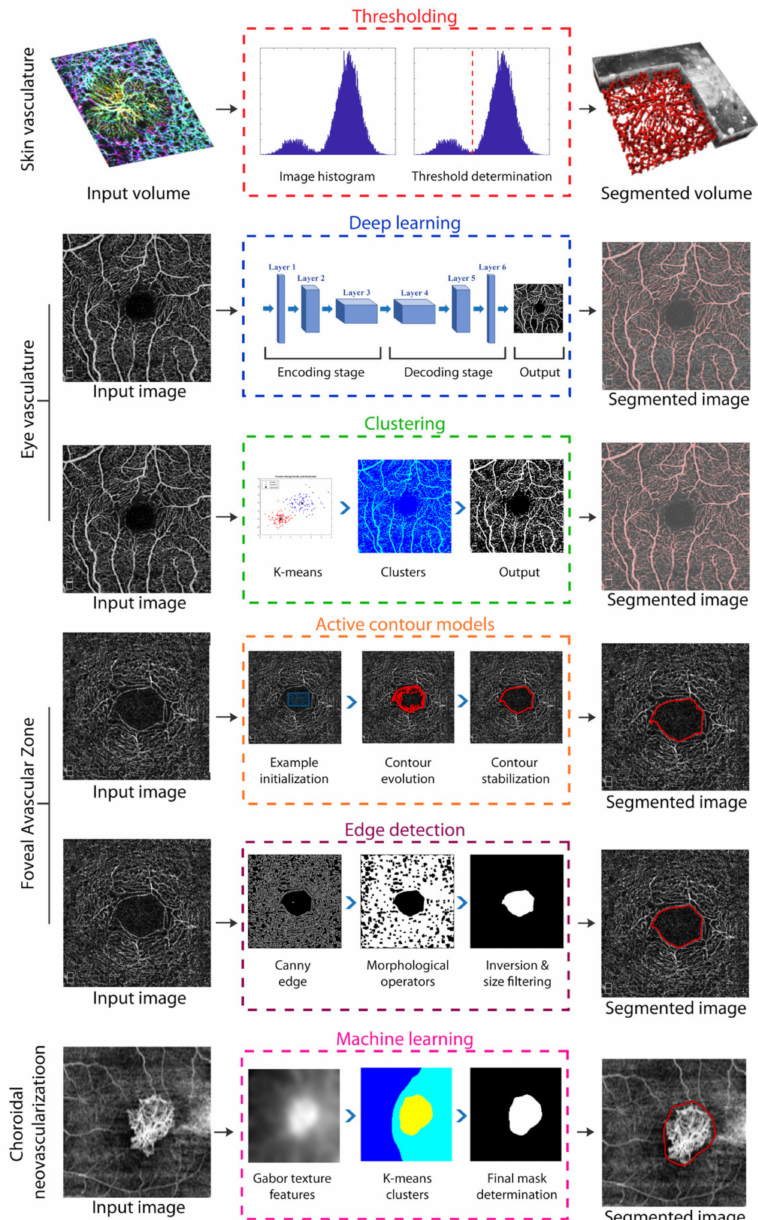
Figure 4. Examples of analyzed segmentation methods and clinical segmentation tasks. Opthalma- logical OCTA images are taken from the open ROSE dataset [13], except for the CNV segmentation task, taken from